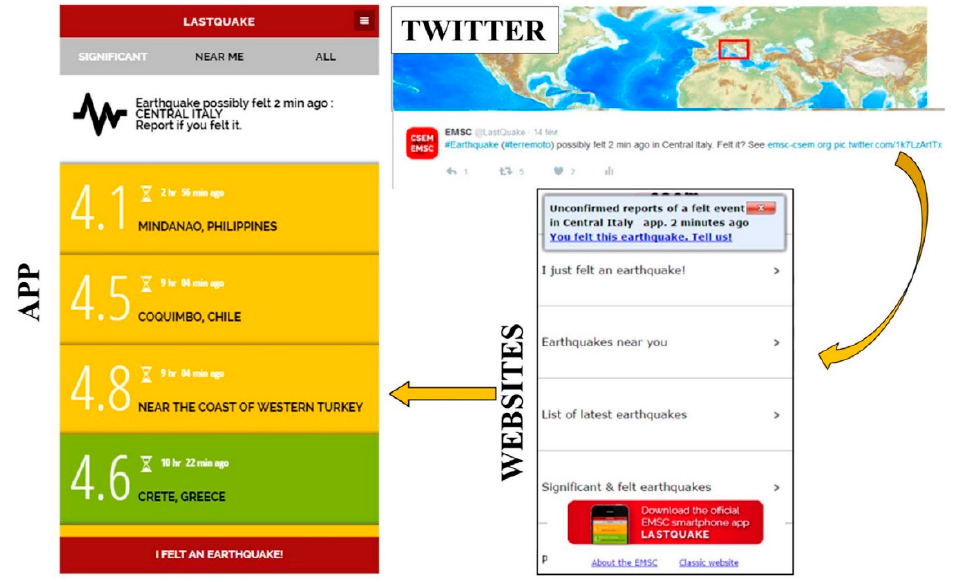
Figure 11. Components of EMSC’s multichannel rapid information system. Source: Figure 3, page